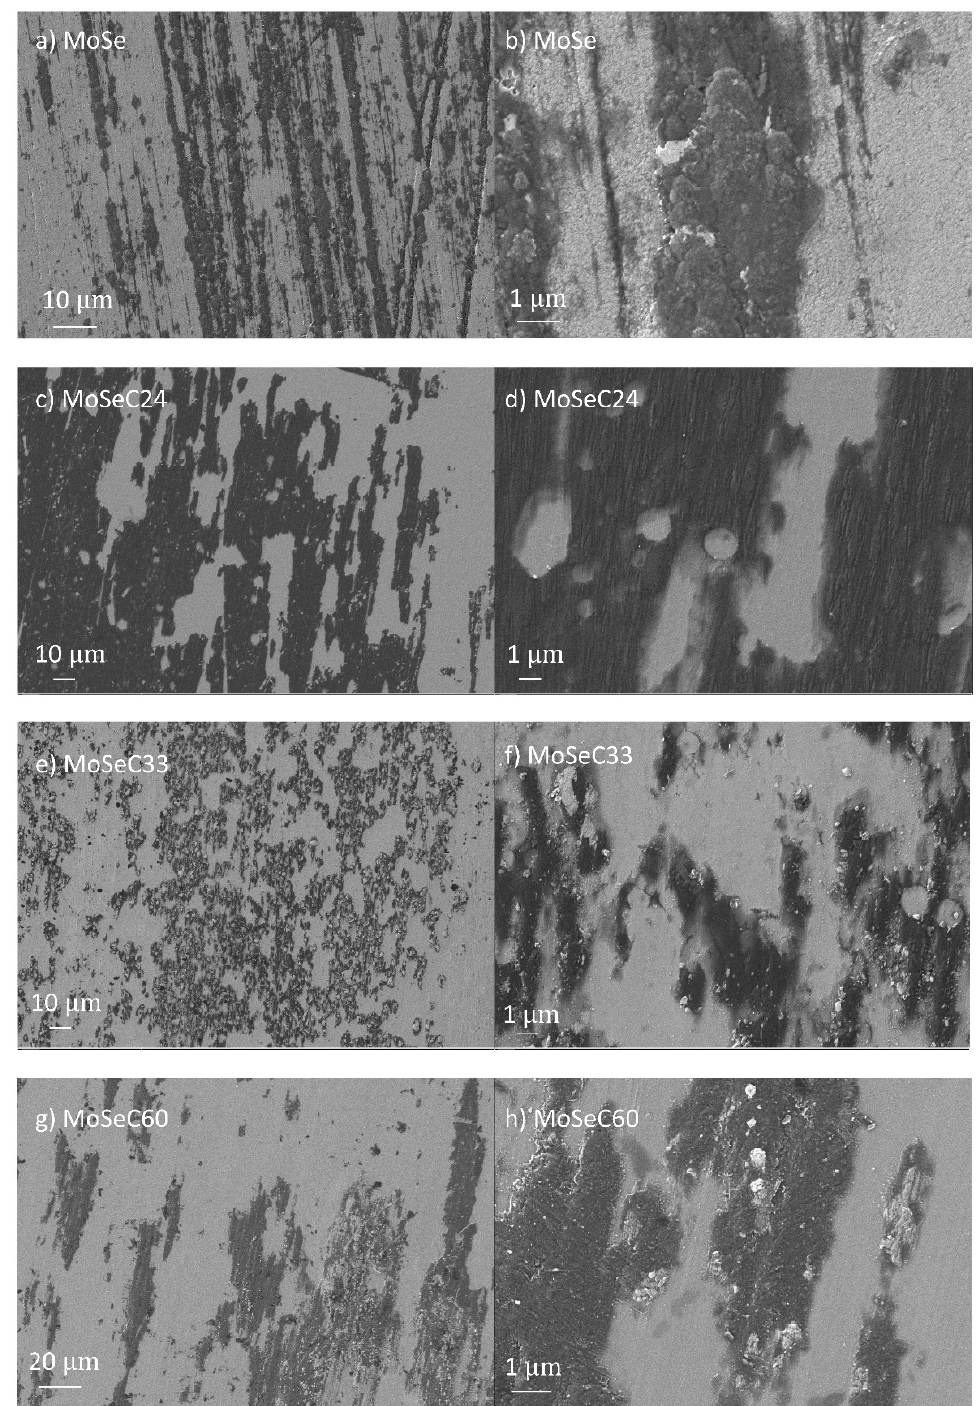
Figure 13. Micrographs of the wear tracks from the coatings, after sliding against rubber, at 200 °C: ( a ) MoSe at lower magnification (LM) imaging; ( b ) MoSe at high magnification (HM) imaging; ( c ) MoSeC24 at LM; ( d ) MoSeC24 at HM; ( e ) MoSeC33 at LM; ( f ) MoSeC33 at HM; ( g ) MoSeC61 at LM; ( h ) MoSeC61 at HM.